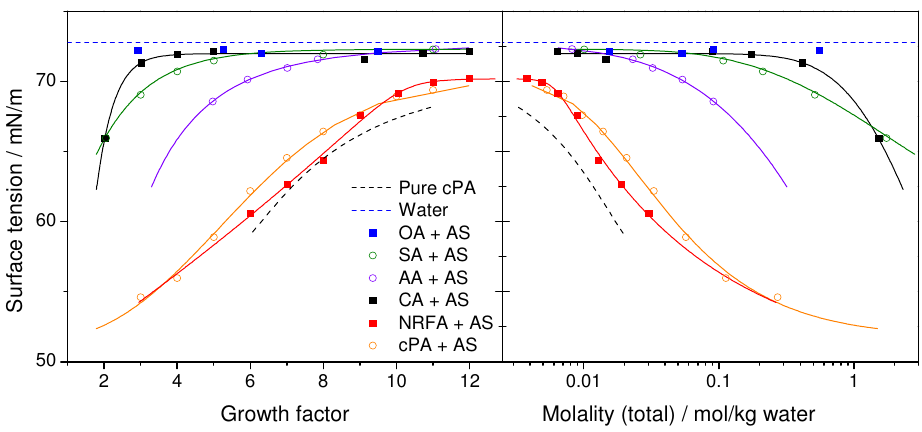
Fig. 1. Measured surface tension of the 50:50 mixtures containing an organic acid and ammonium sulphate (abbreviations are explained in Table 1). Continuous lines based on empirical fits (see Table 3) are included to aid visual inspection. A parameterization of the surface tension of pure cis-pinonic acid in aqueous solution (Varga et al., 2007) is included for comparison.